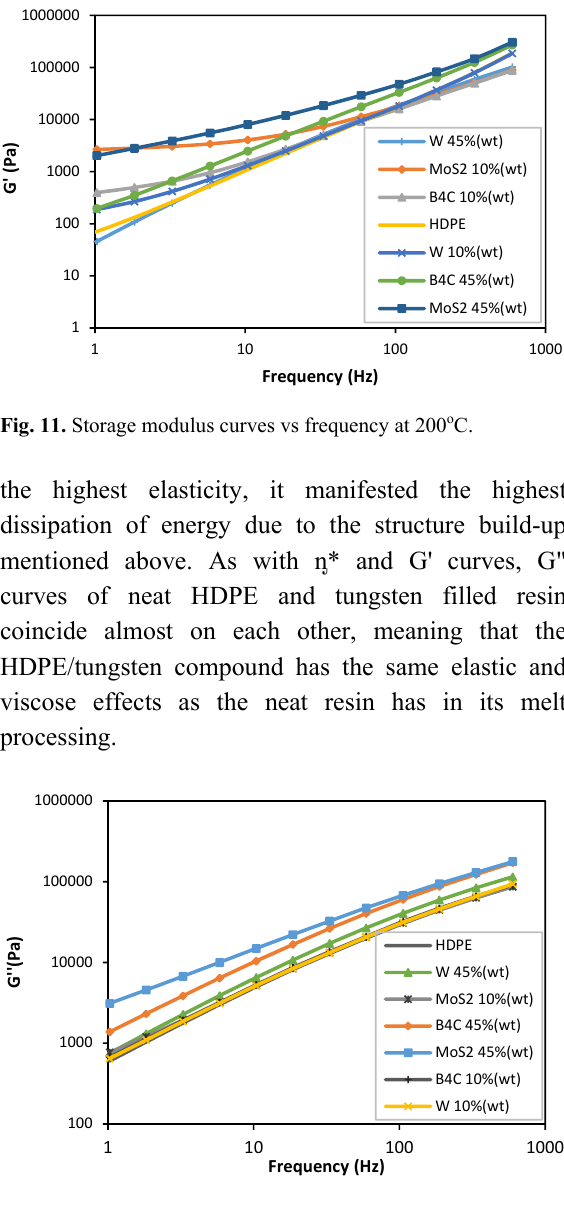
Fig. 12. Loss modulus curves vs frequency at 200 o C.